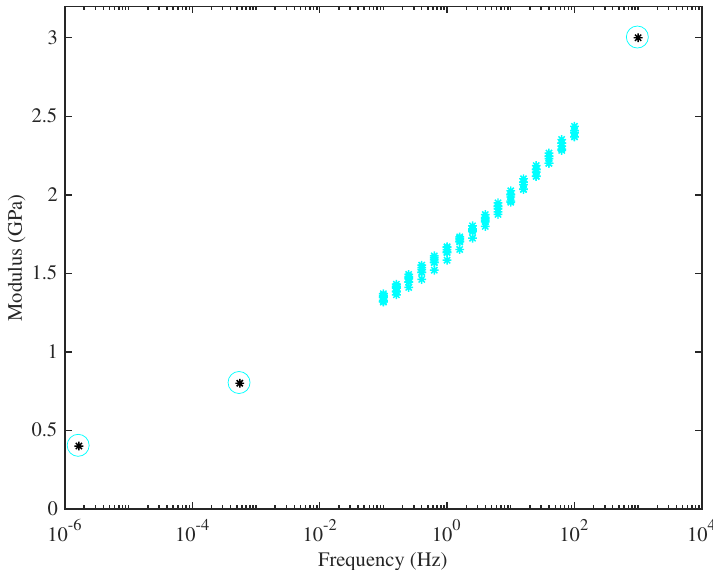
Figure 9. Ambient-temperature measurements of the real part of Young’s modulus of String 29 (E3) as a function of frequency: Dynamical Mechanical Analyser (DMA) tests from the same configuration as in Figure 8 (cyan stars); results from the measurements of E S , E T and E B , extrapolated to zero axial stress (circles with central black stars). The DMA frequency sweep was repeated several times, indicated by the multiple plotted